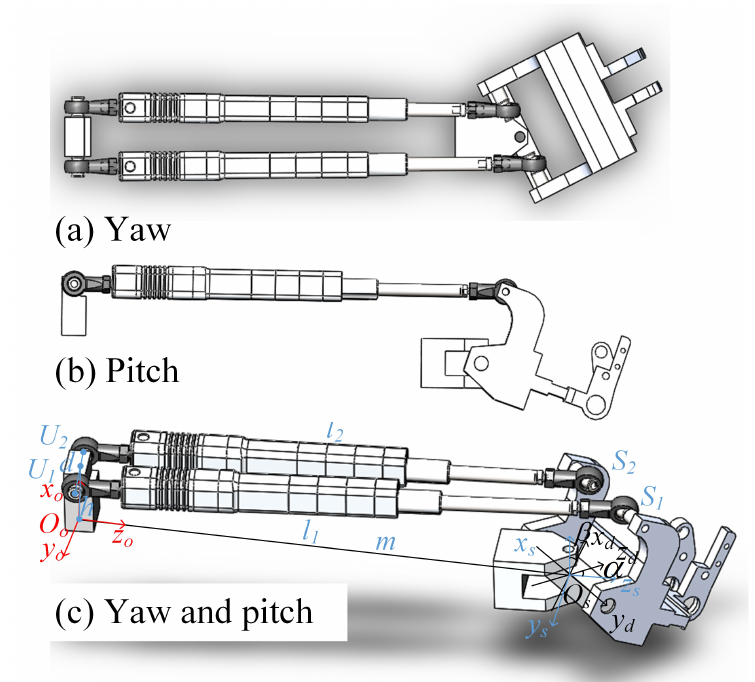
Figure 5. Two degrees of freedom of the 2-SPS parallel mechanism. ( a ) The yaw motion is controlled via differential displacement of the two actuators. ( b ) The pitch motion is controlled via the displace- ment away from the initial position. ( c ) The orientation is achieved via simultaneous control of the two